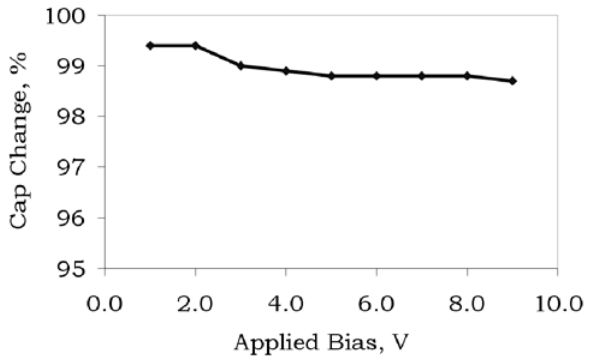
FIGURE 8 Bias dependency of MnO 2 coated NbO parts (150uF = 10V).